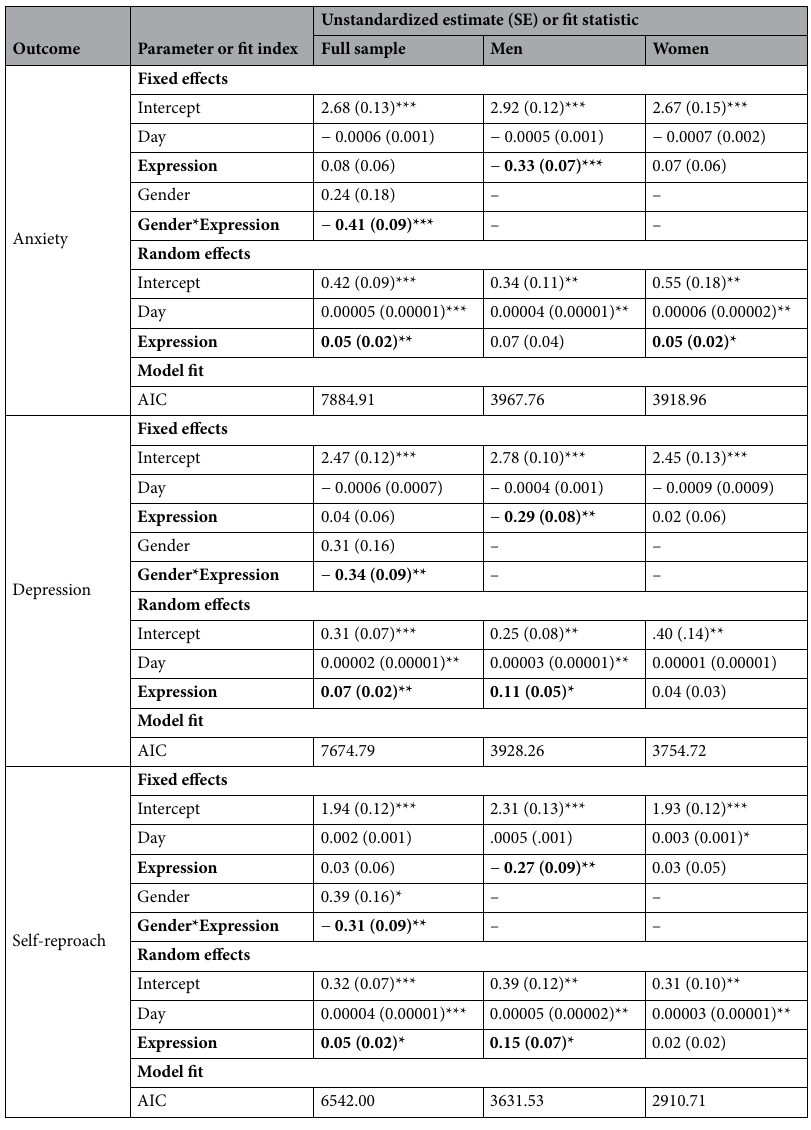
Table 1. Multilevel model results for the sample-level link between daily gender expression (feminine-to- masculine continuum) and three indices of psychological adjustment by gender. Significant effects concerning gender expression (i.e., feminine-to-masculine continuum) are bold, and significant interactions in the full sample were probed with separate follow-up analyses in men and women. *p < 0.05; **p < 0.01; ***p < 0.001 .